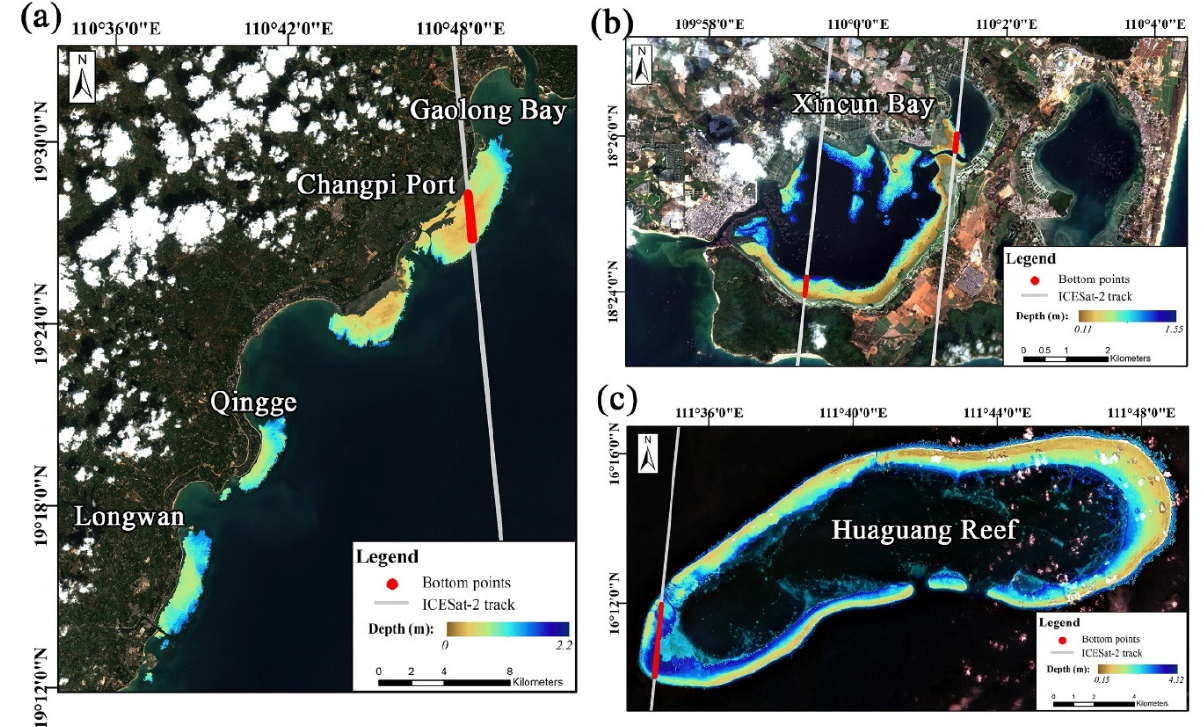
Figure 11. The retrieved depth from the developed model for OSWs of ( a ) Changpi Port and the surrounding shallow waters; ( b ) Xincun Bay; ( c ) Huaguang reef. The gray lines represent the ICESat-2 track, which just passes through the corresponding region, and the bottom points are highlighted with red dots.